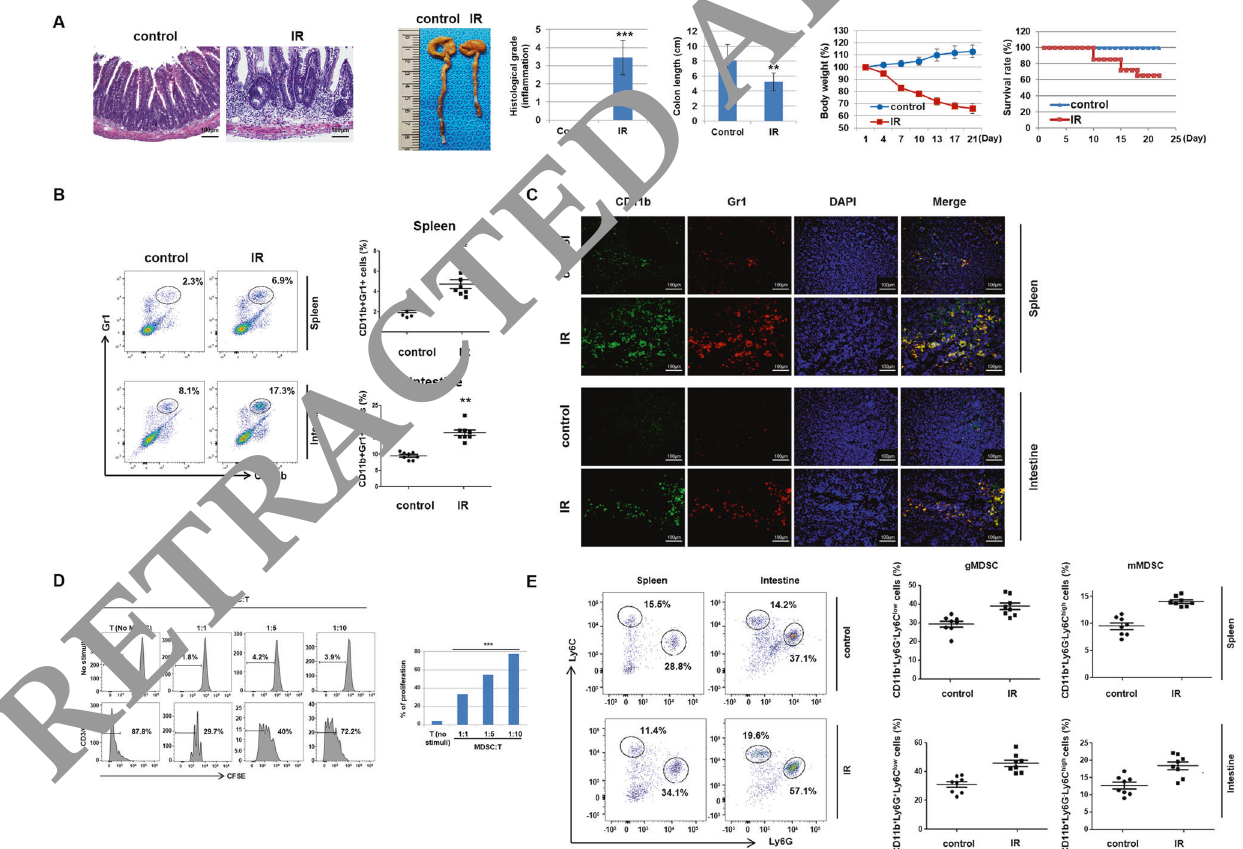
Fig. 1 Radiation increases intestinal in fl ammation that is accompanied by MDSC expansion. Mice were exposed to 7.5 Gy for 1 week to induce intestinal in fl ammation. A Photomicrographs of colon sections, histological grades, colon lengths, body weights, and survival rates for mice 21 days after irradiation. Scale bar = 100 μ m B Representative dot plots of the gating strategy used to identify CD11b + /GR1 + cells from the spleens and intestines of mice 21 days after irradiation. C Representative immuno fl uorescence images of spleen and intestine stained for CD11b (green), GR1 (red), and CD11b + /GR1 + (yellow) cells. DAPI staining (blue) was used to determine the number of nuclei. Scale bar = 100 μ m D CFSE-labeled CD3 + T cells were co ‑ cultured with splenic MDSCs and stimulated using anti-CD3 and anti-CD28 monoclonal antibodies. The cells were harvested and analyzed after 7 days. CFSE dilution demonstrated that T-cell proliferation was inhibited by MDSCs (left) and that this inhibition occurred in a dose-dependent manner (right). E The two MDSC subtypes, namely gMDSCs (CD11b + , Ly6G + , and Ly6C low ) and mMDSCs (CD11b + , Ly6G - , and Ly6C high ), were identi fi ed and analyzed by fl ow cytometry from spleen and intestine samples. The data are represented as the mean ± SD (n = 8). * P < 0.05, ** P < 0.01, *** P < 0.001 vs. control. IR